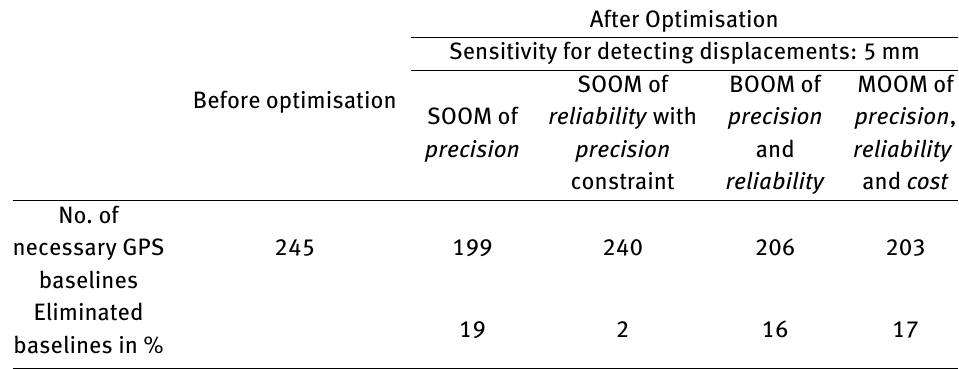
Table 1: Results of different optimisation techniques performed on the GPS